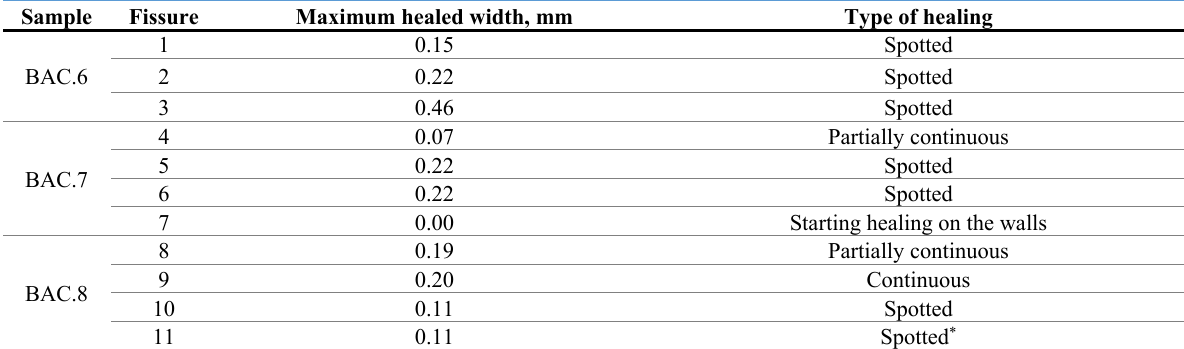
Table 4 – Synthesis of visual analysis